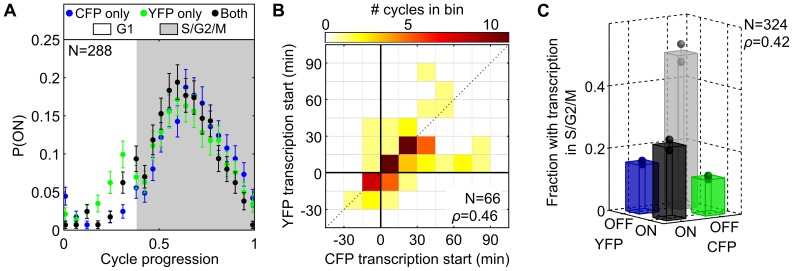
Transcriptional bursts from homologous loci are cell-cycle dependent and partially correlated.The 3-color diploid strain was grown in microfluidics with 50 ng/mL dox, reducing expression from P7xtetO. (A) The probability that each P7xtetO's transcription rate is above background (Text S1), computed by averaging binarized individual cell responses (ON = 1, or OFF = 0) in each cell-cycle progression bin, increases after G1. (B) A 2D histogram of activation time for each promoter when both activate (t = 0 at budding). Most activation occurs near budding and is correlated. (C) Classifying all single-cell S/G2/M periods (from (A) plus those following an unobserved G1) by whether each P7xtetO activates reveals correlations in sporadic expression. Error bars represent SEM from bootstrapping.